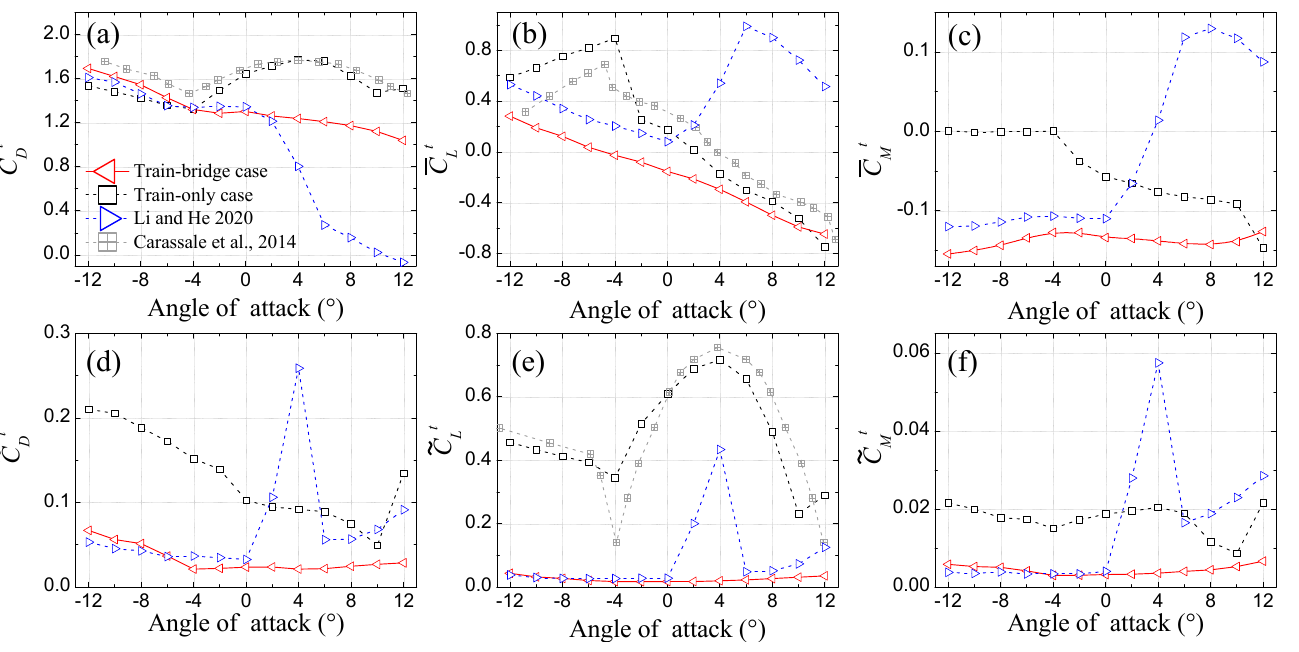
Figure 8. Aerodynamic force coefficients of the train model: ( a ) Mean drag coefficients; ( b ) Mean lift coefficients; ( c ) Mean moment coefficients; ( d ) Fluctuating drag coefficients; ( e ) Fluctuating lift coefficients; and ( f ) Fluctuating moment coefficients.